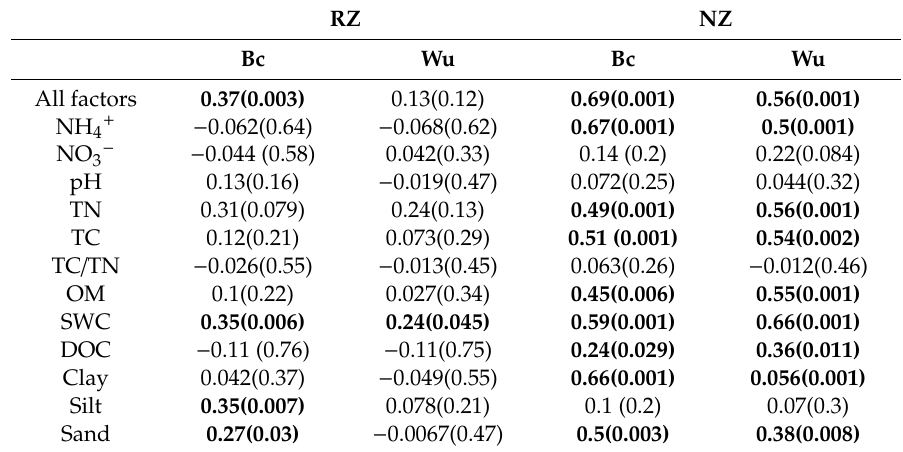
Table 1. Mantel tests for the relationship between bacterial community dissimilarities and local factors. Bacterial community dissimilarity was calculated based on Bray–Curtis distances (BC) and on Weighted UniFrac distances (WU). RZ NZ Bc Wu Bc Wu All factors